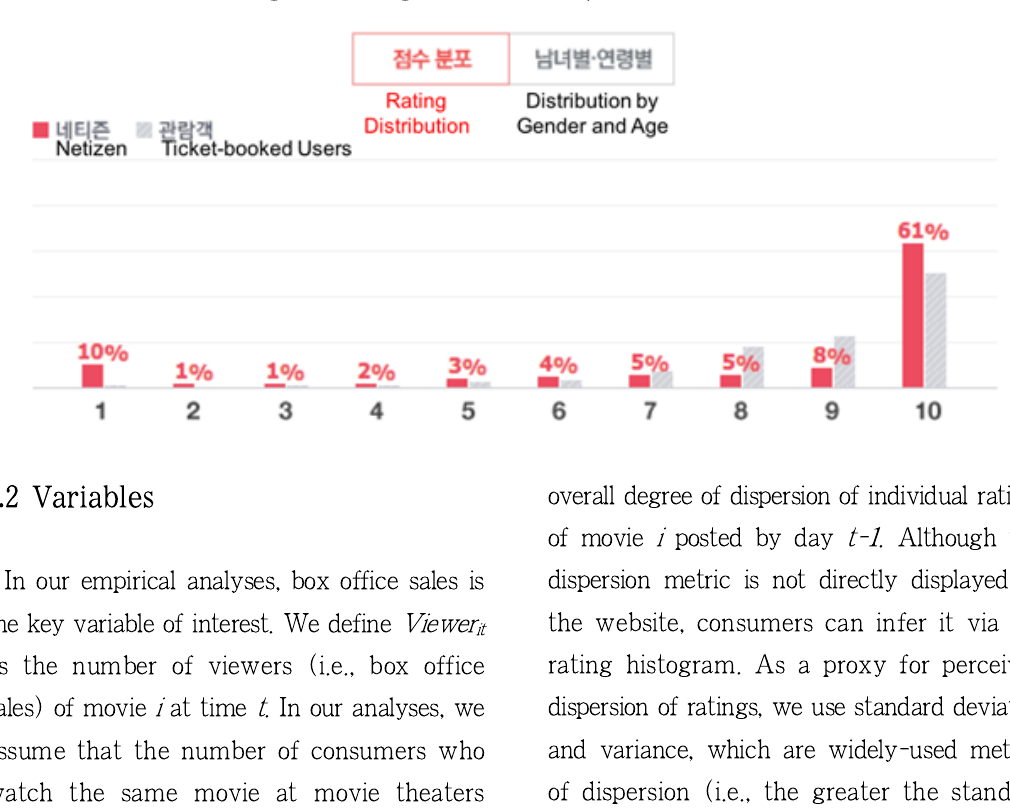
<Figure 2> Rating Information Example on Naver